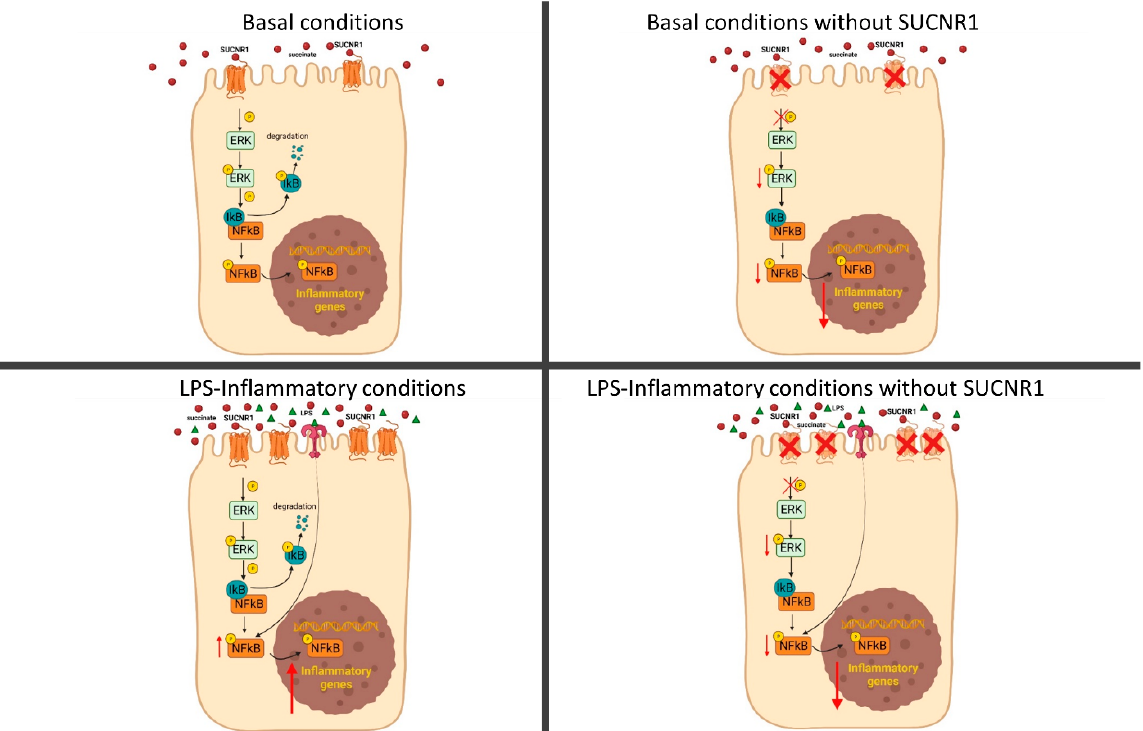
Figure 7. The activation of SUCNR1 by constitutive levels of succinate regulates ERK and NF к B phosphorylation in non-stimulated epithelial cells. In LPS-treated cells, there is an upregulation of SUCNR1 which increases the phosphorylation of ERK and NF к B, with the subsequent expression of proinflammatory genes.